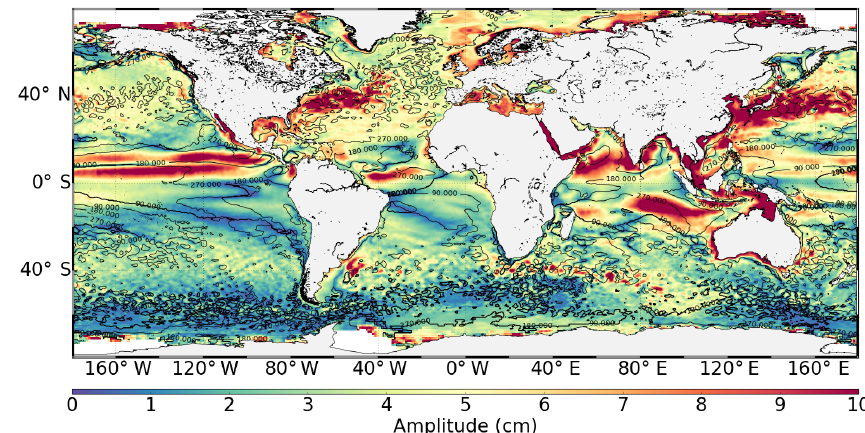
Figure 3. Global amplitude (coloured contours, between 0 and 10cm) and phase (superimposed black isolines, between 0 and 360 ◦ ) of the annual cycle of the SL_cci ECV v2.0 during 1993–2015.